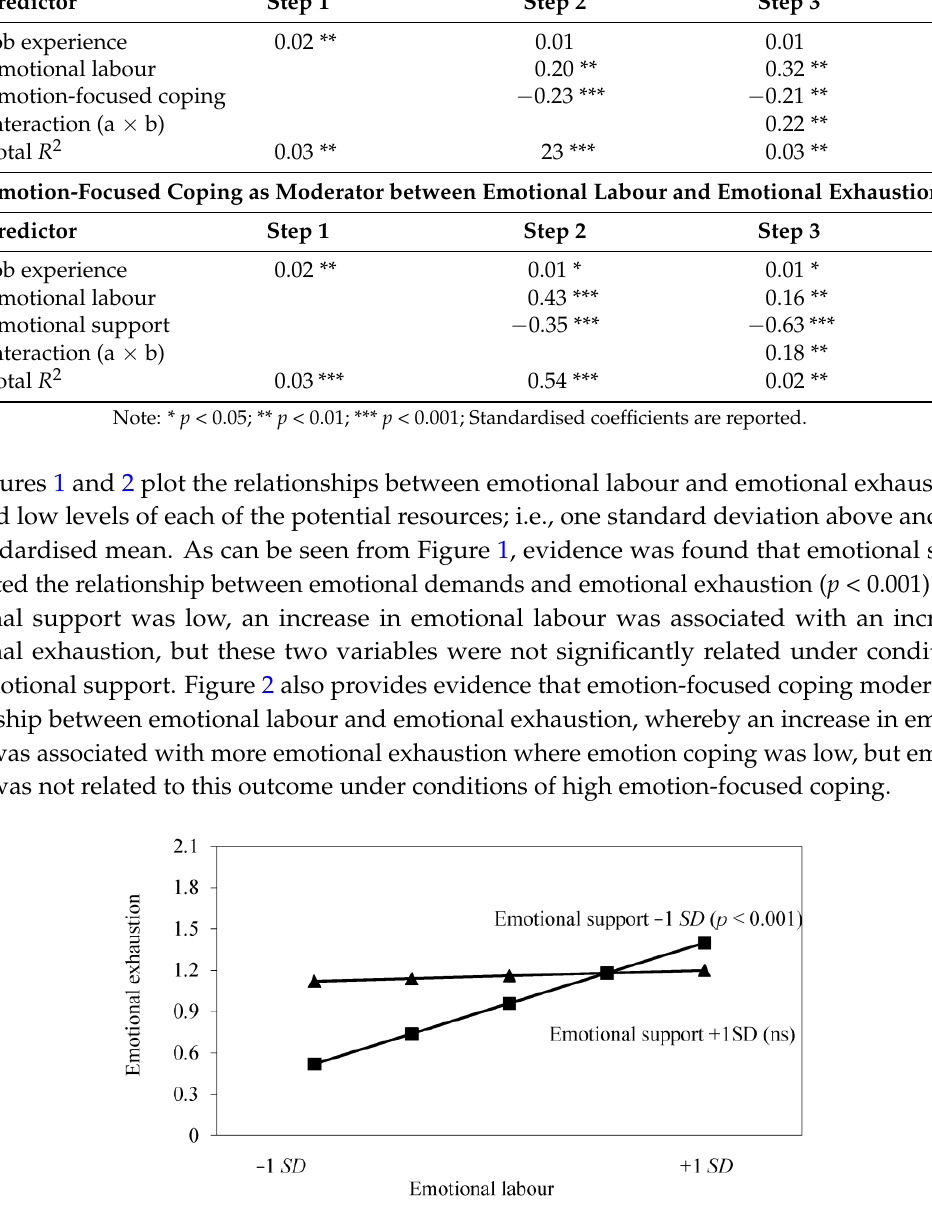
Figure 1. Interaction effect of emotional labour and emotional support on emotional exhaustion.